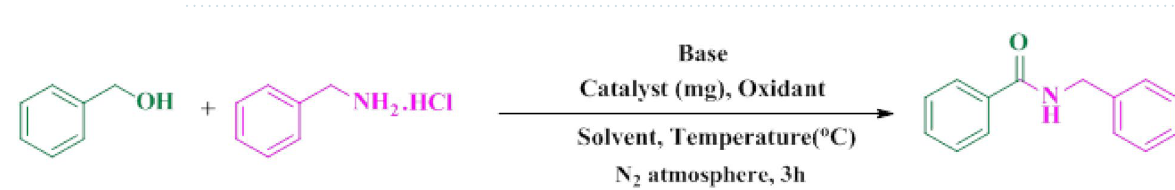
Figure 5. ( a ) XRD patterns of CN, β-CD, CN-Pr-β-CD/Cu(II), ( b ) TGA patterns of CN, ( c ) TGA patterns of CN-Pr-β-CD/Cu(II) and, ( d ) N